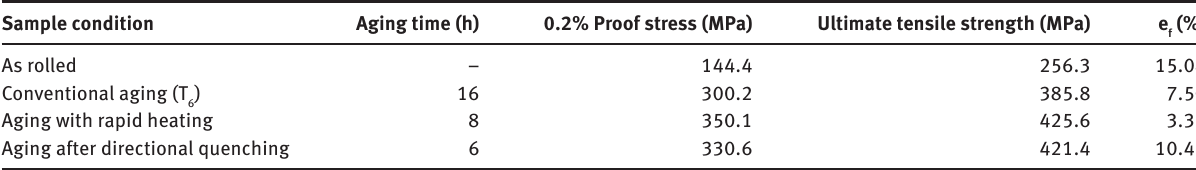
under different conditions. p